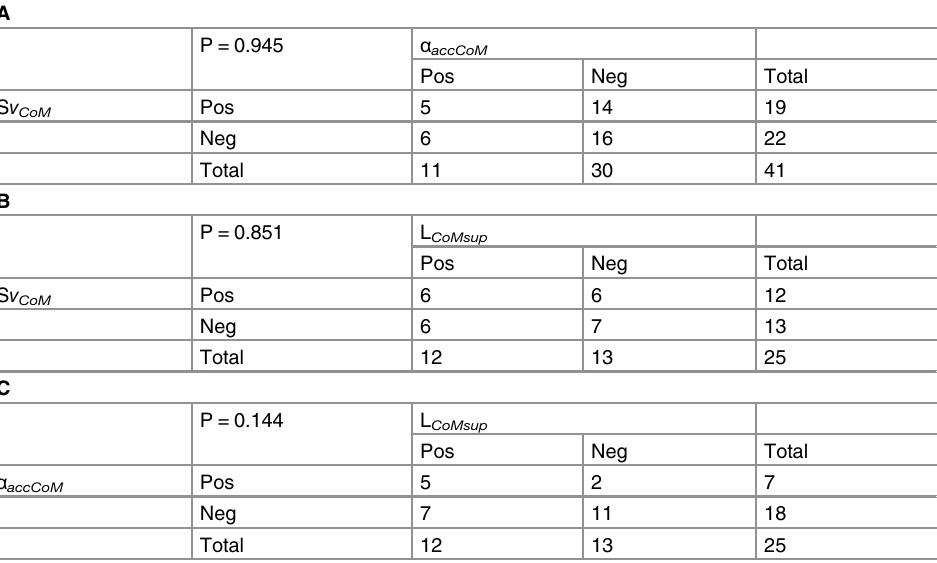
both functions. L CoMsup was only fi tted satisfactorily in 25. Tables A, B and, C compare two of the